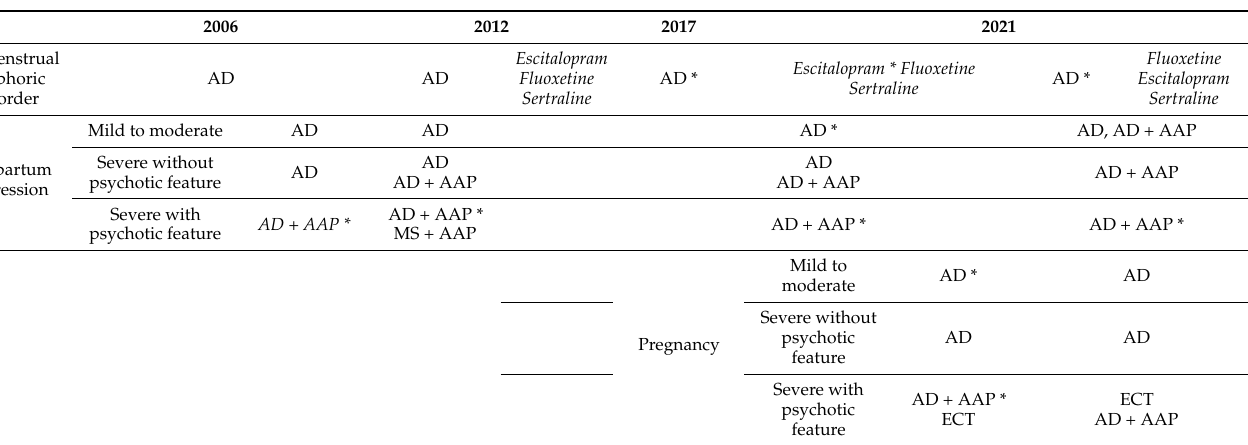
Table 6. First and second-line treatment strategies for females of